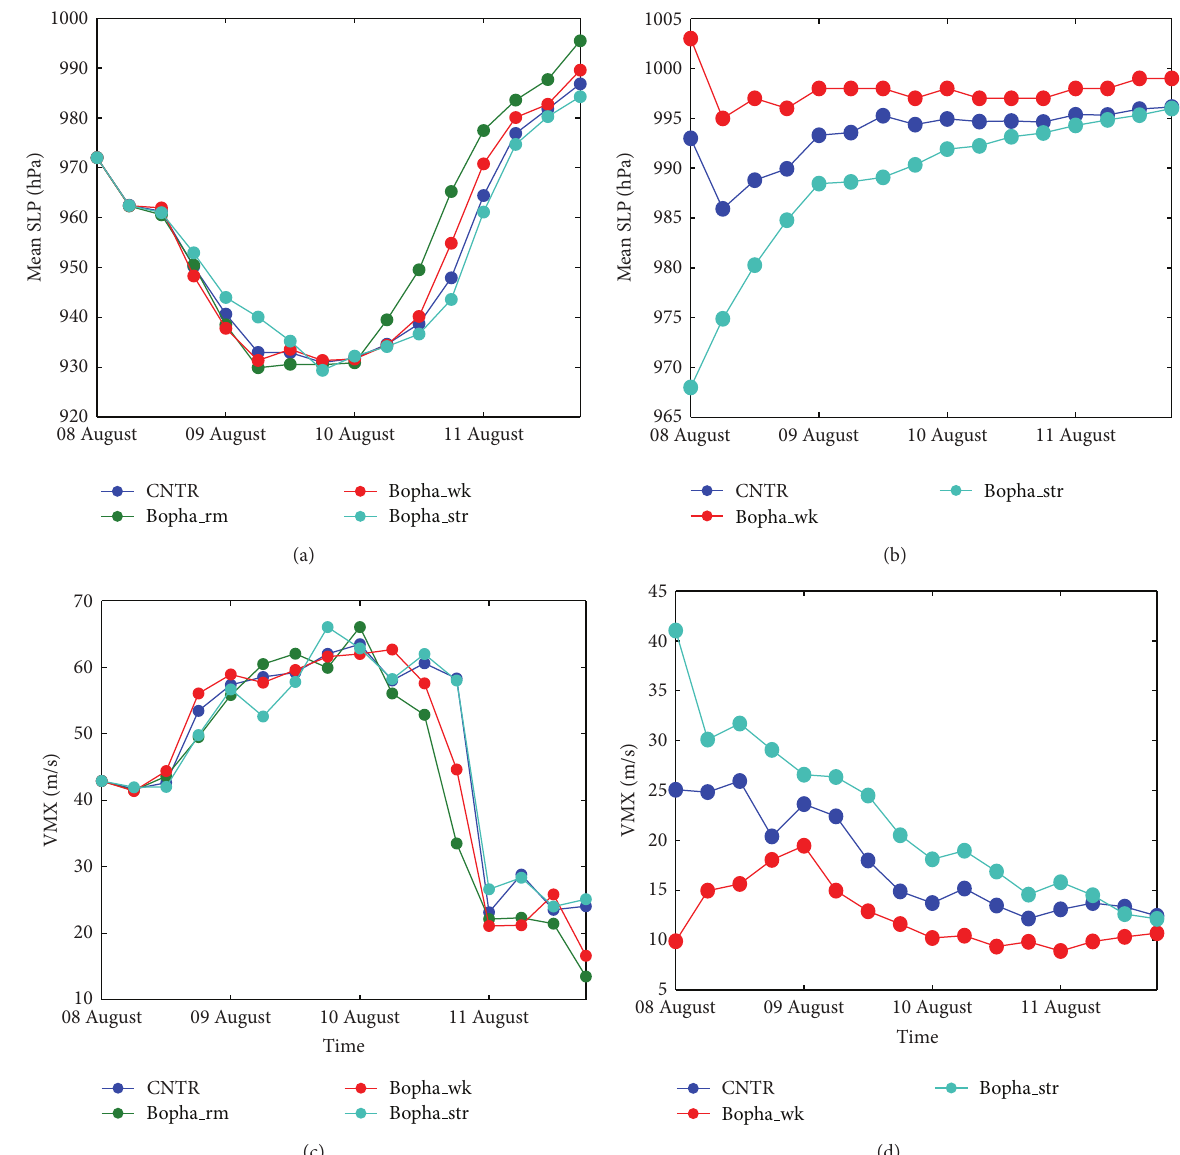
Figure 5: The 6-hourly minimum sea-level pressure (hPa) of Saomai (a) and Bopha (b) in each experiment from 0000 UTC 8 August to 1800 UTC 11 August, 2006. (c) and (d) are corresponding to (a) and (b) except for 10-meter maximum wind.